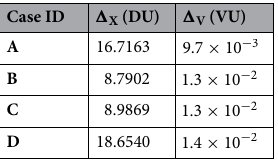
Table 5. Case studies: autonomous guidance